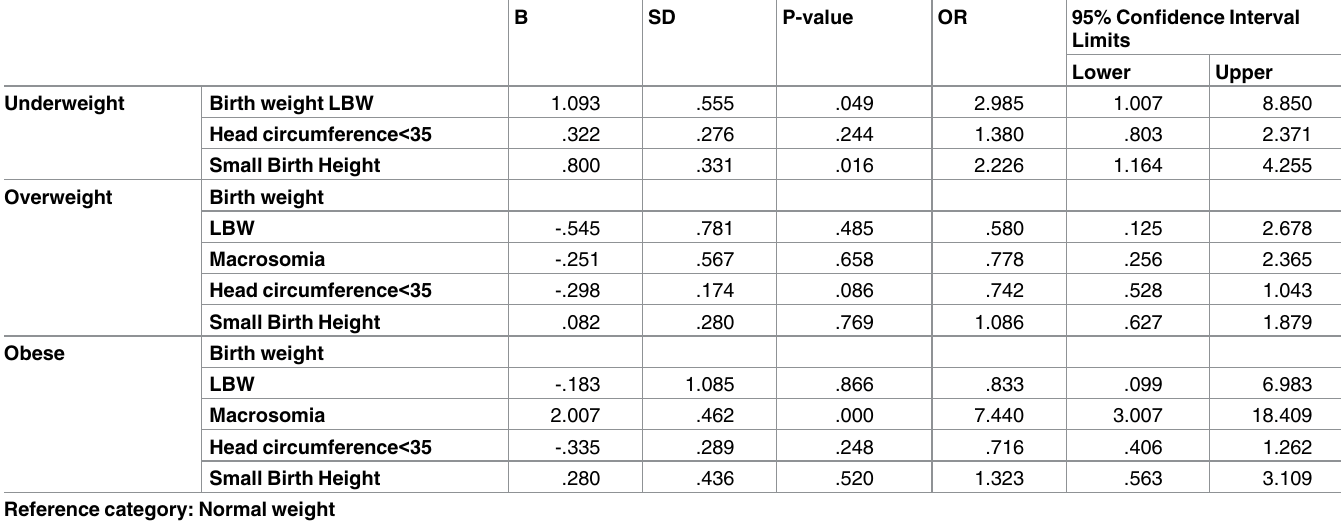
Table 7. Multivariate logistic regression analysis of the association between pregestational BMI and neonatal outcomes.